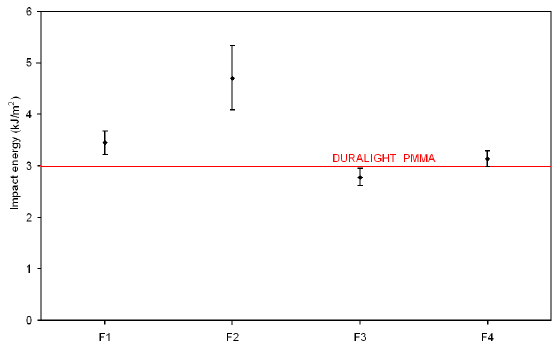
Figure 4. Charpy impact results.